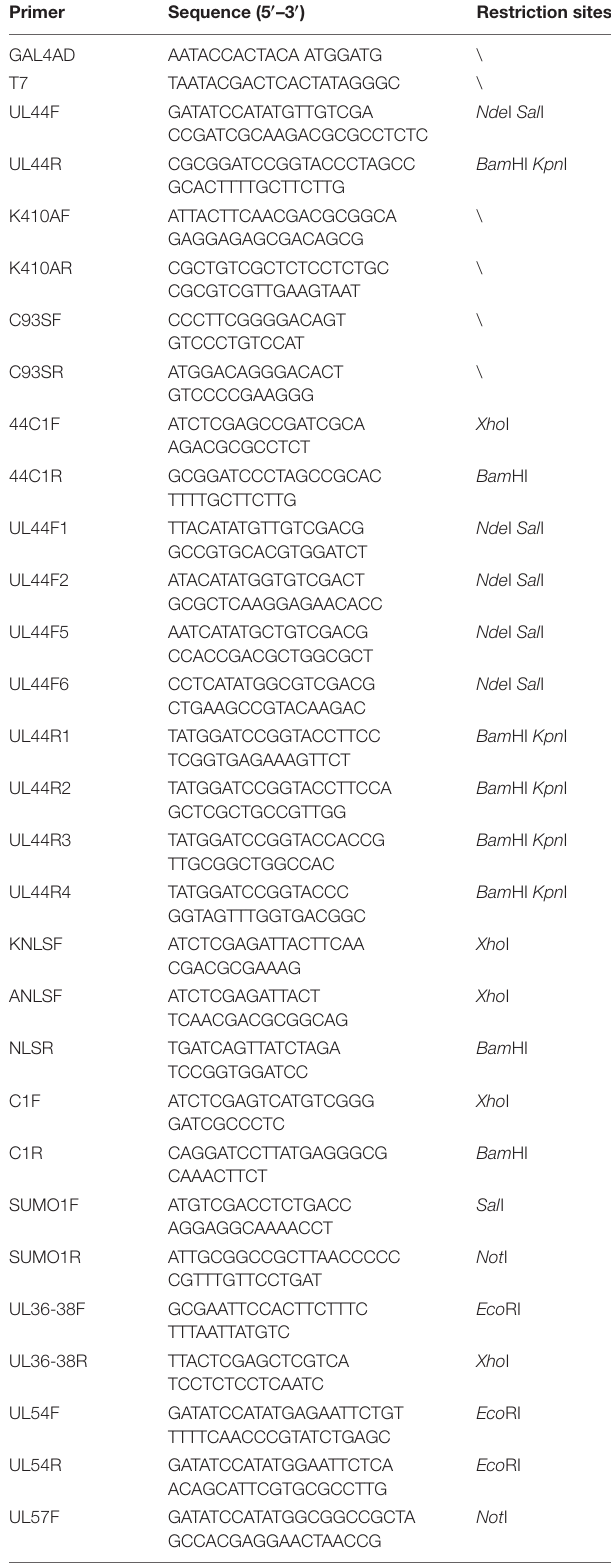
TABLE 1 | Primers used in the